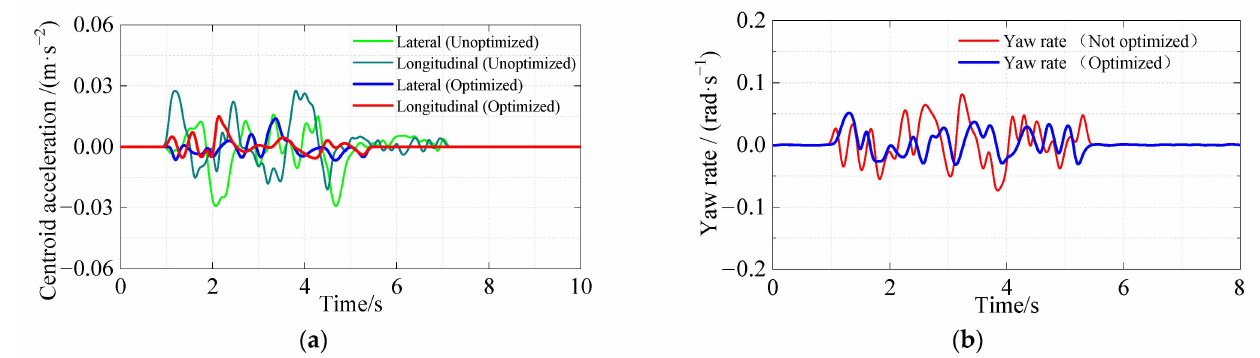
Figure 11. The centroid acceleration and yaw rate changes of the chassis during MMS: ( a ) Centroid acceleration, ( b ) Yaw